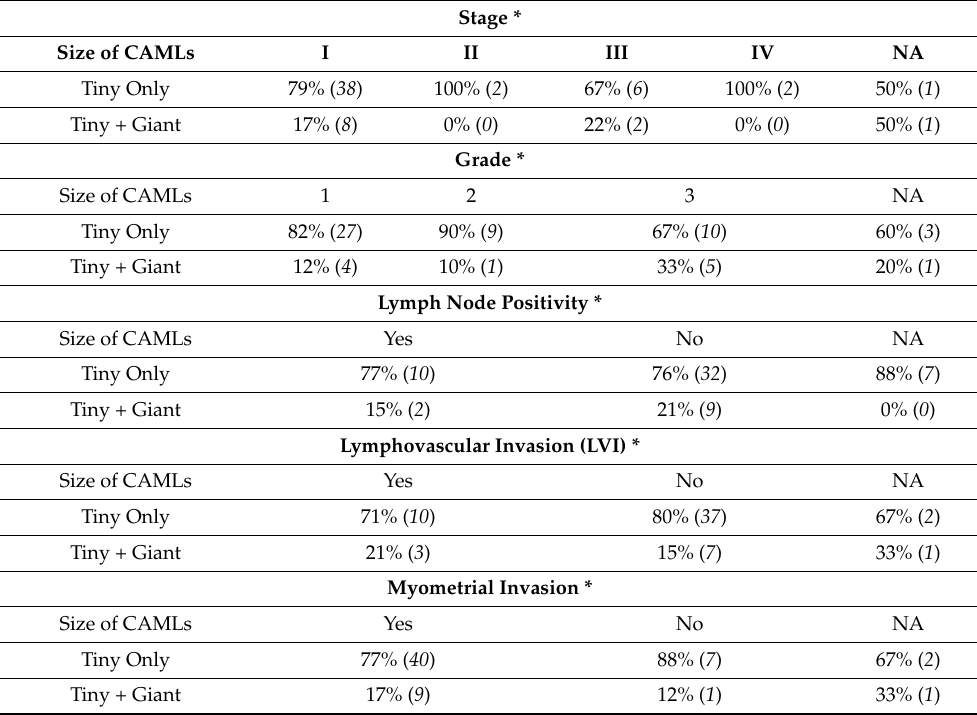
Table 4. Distribution of subtypes of CAMLs in the blood of patients with endometrial cancers with different stages, grades, lymph node positivity, lymphovascular invasion (lvi), and myometrial